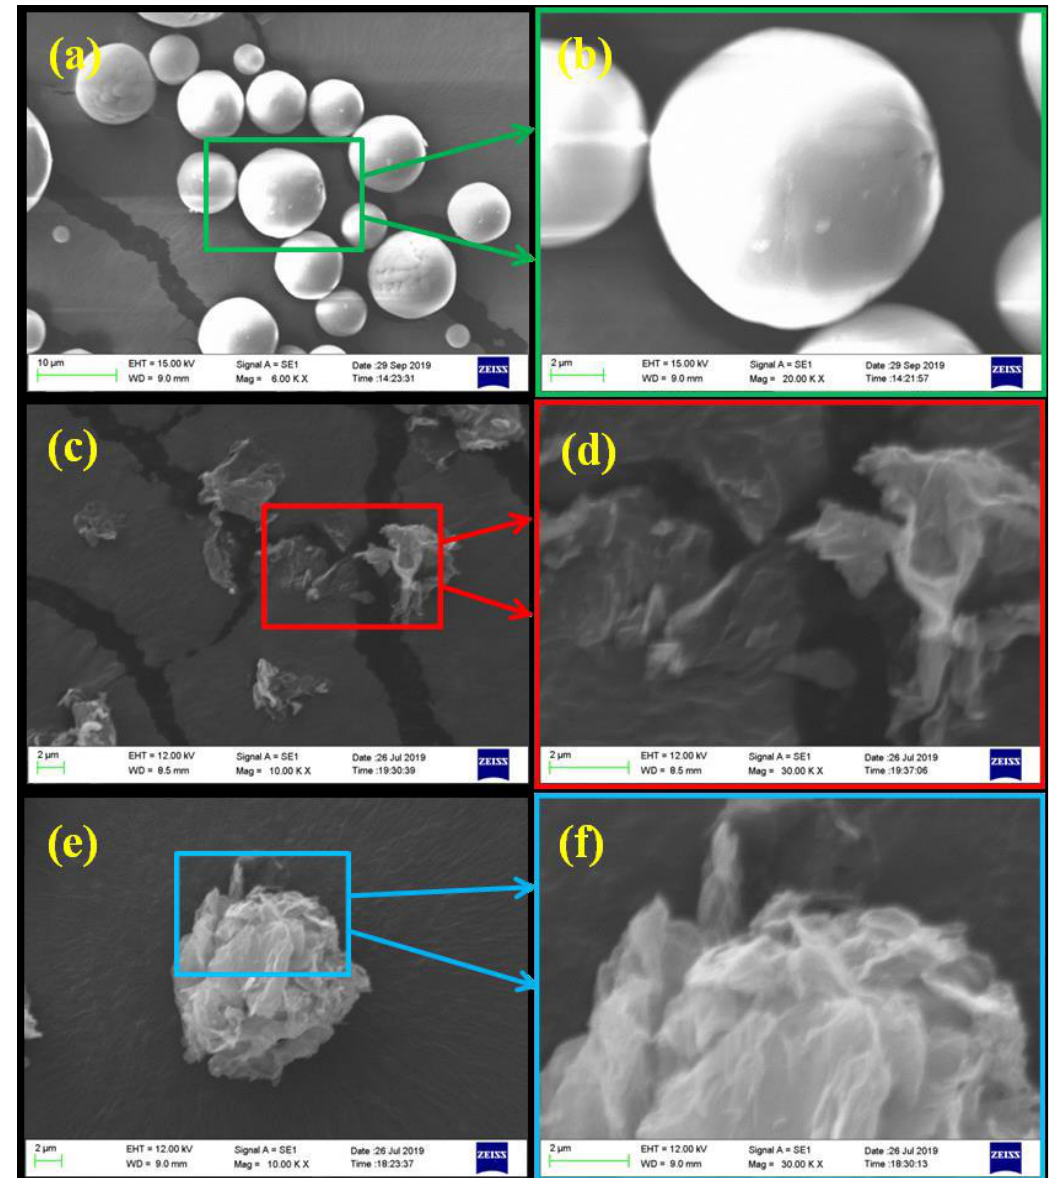
Figure 2. SEM images of ( a , b ) S-Al 2 O 3 , ( c , d ) RGO and ( e , f ) GFRGO.